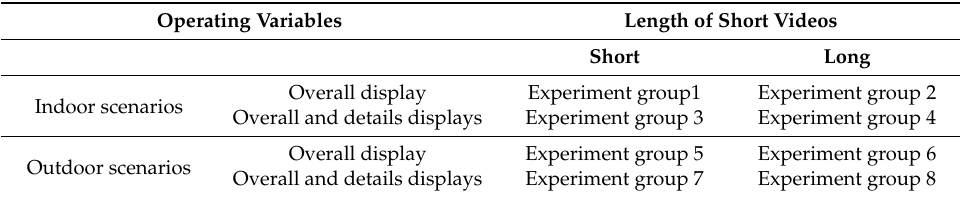
Table 2. Experimental design and groups.